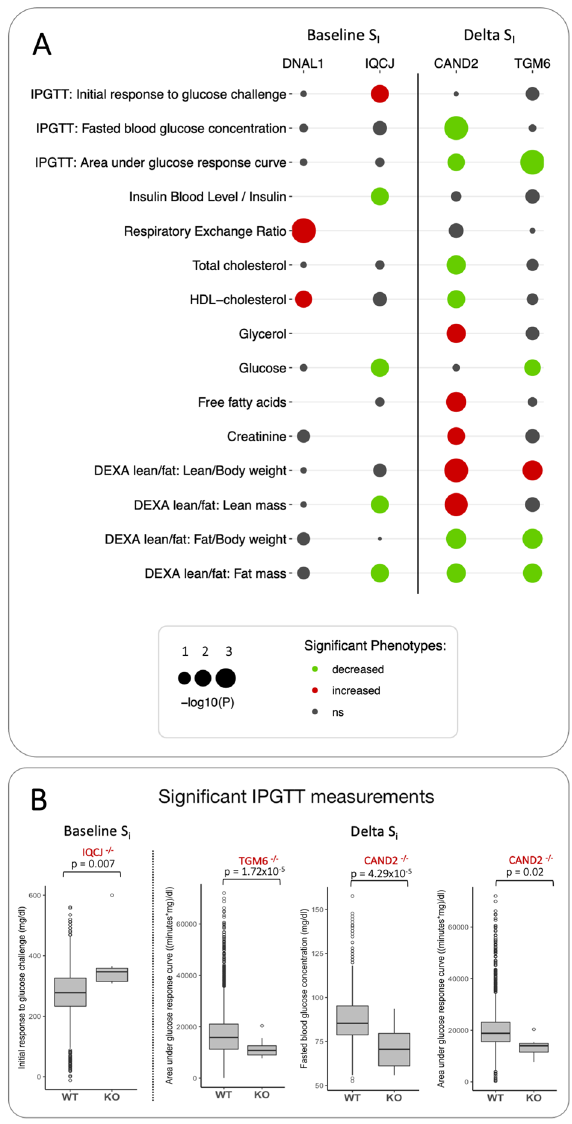
Figure 3. Validation of gene candidates from GWAS analysis in a mouse knock down experiment database. ( A ) Mouse knockout of DNAL1 and IQCJ (associated with baseline S i ) and CAND2 and TGM6 (associated with ∆S i ) lead to changes related to metabolism and skeletal muscle development (P adj < 0.05, ns = not significant). Details of each experiment can be found in the IMPC database 18 . ( B ) Boxplots detailing significant associations of IQCJ, CAND2 and TGM6 knockouts with measurements from IPGTT (intra-peritoneal glucose tolerance test) experiment in mice, which is analogous to intravenous glucose tolerance test (IVGTT) method used to measure S i in study